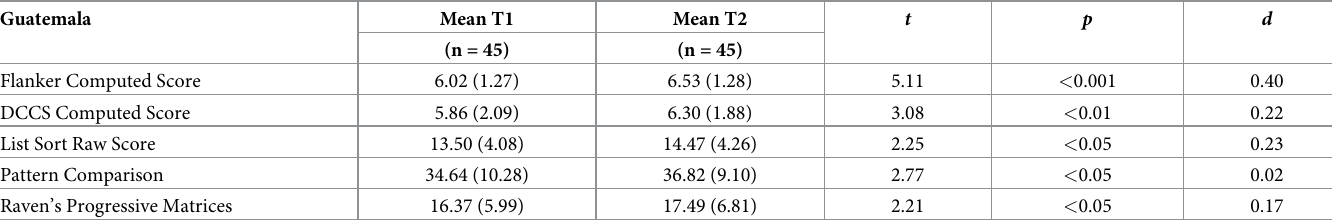
Table 5. Mean (SD) for assessment scores over time for